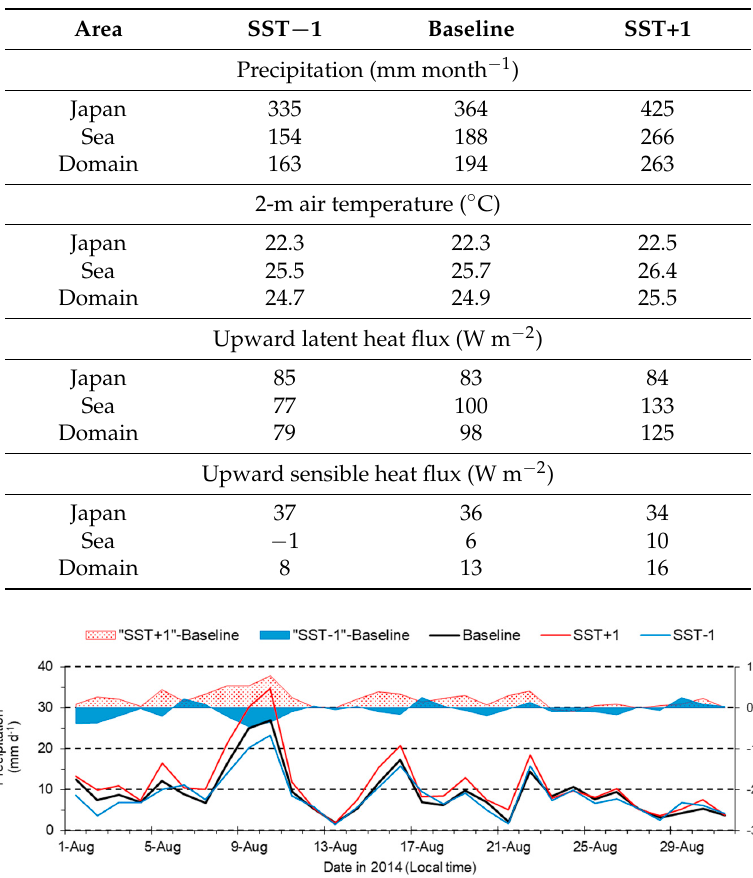
Figure 6. Temporal variations of daily precipitation averaged for all the meteorological observatories in August 2014 for the comparison of the baseline, SST+1, and SST − 1 cases. The second axis indicates the precipitation difference from the baseline condition (“SST+1”—Baseline, “SST − 1”—Baseline).